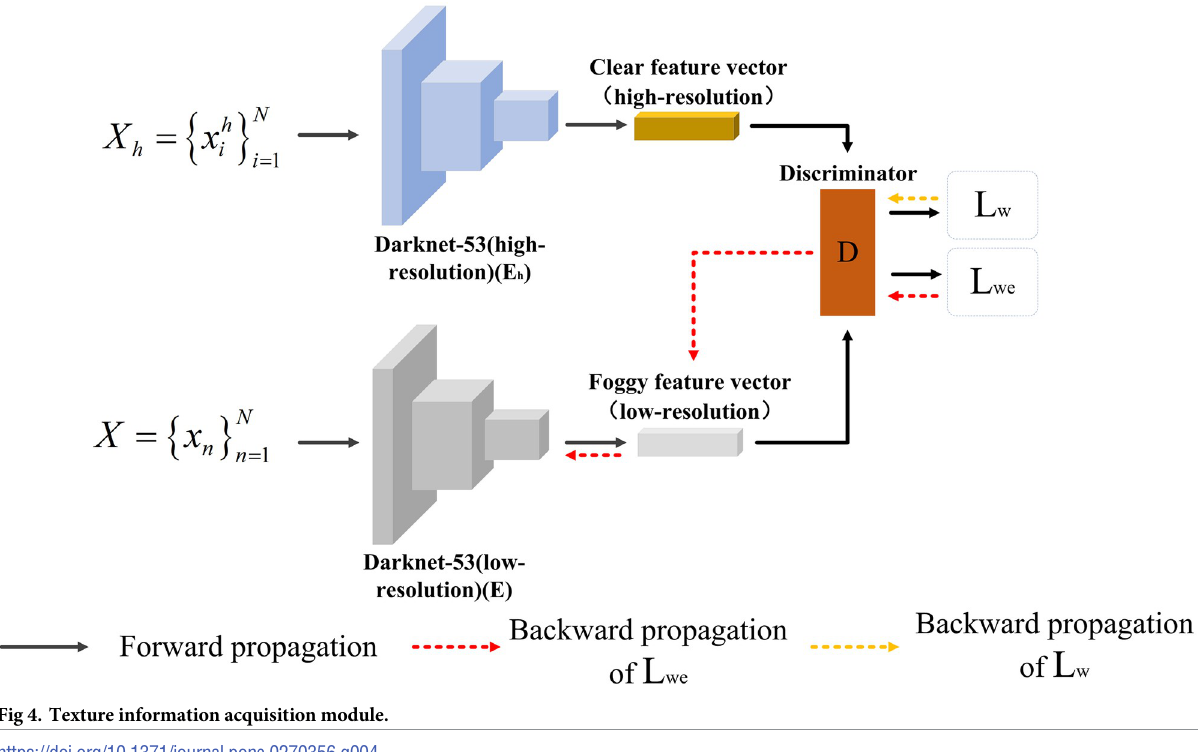
Fig 4. Texture information acquisition